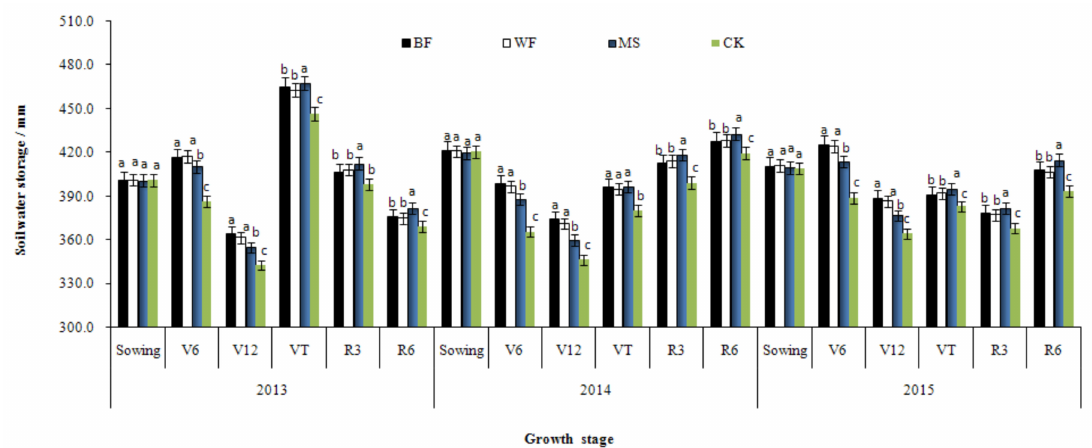
Figure 2. Soil water content dynamics in 0–200 cm layers for di ff erent treatments at six maize-growing stages during 2013–2015. The error bars are the standard errors. Di ff erent lowercase letters indicate significant di ff erences at the 0.05 ( p < 0.05) level among di ff erent mulching treatments within the same growth